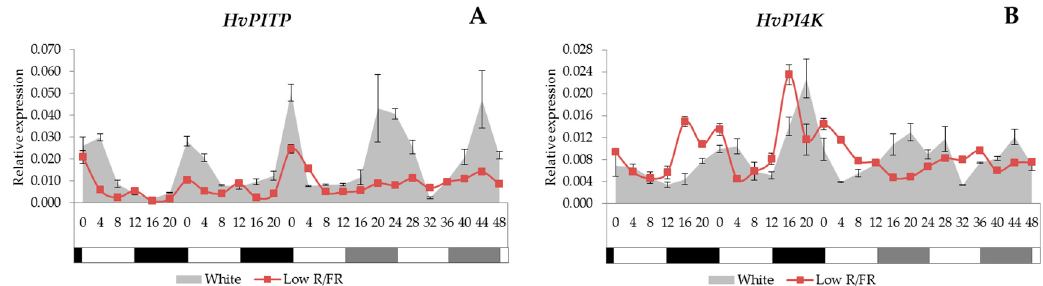
Figure 2. The expression patterns of HvPITP and HvPI4K genes ( A , B ) with white light and low R/FR illumination. Conditions are the same as in Figure 1.